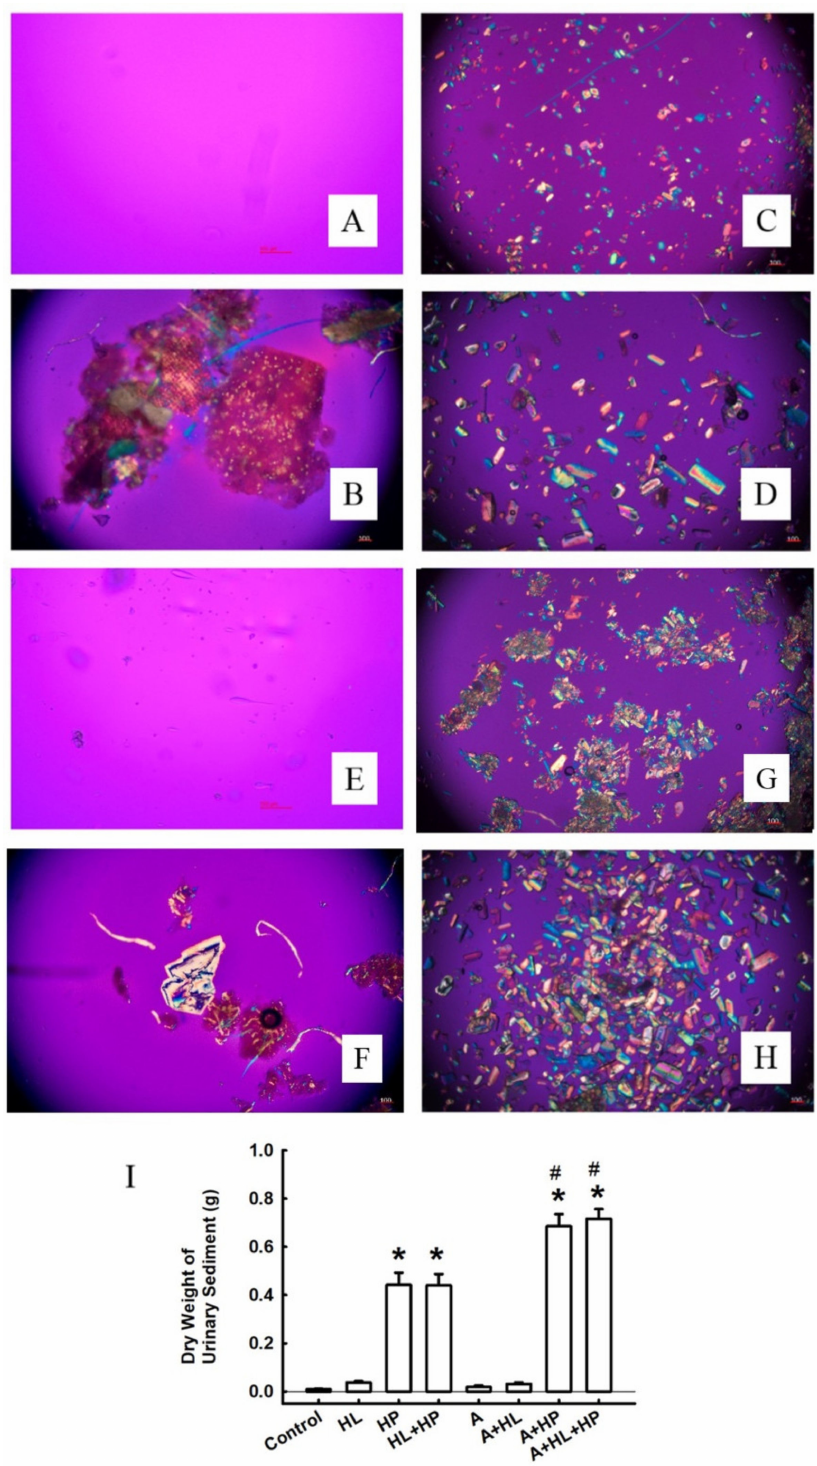
Figure 2. Representative micrographs of calcium crystals in urine sediments photographed using a polarized microscope. ( A ) Control. ( B ) Hyperlipidemia (HL). ( C ) Rats treated with 5% hydroxyproline (HP). ( D ) HL rats treated with 5% HP. ( E ) Controls treated with atorvastatin. ( F ) HL rats treated with atorvastatin. ( G ) Rats treated with 5% HP and atorvastatin. ( H ) HL rats treated with 5% HP and atorvastatin. All images above were demonstrated with original magnification 100 × . ( I ) Statistical result for the dry weight of urine sediments. * p < 0.05 versus the control group; # p < 0.05 versus the controls treated with